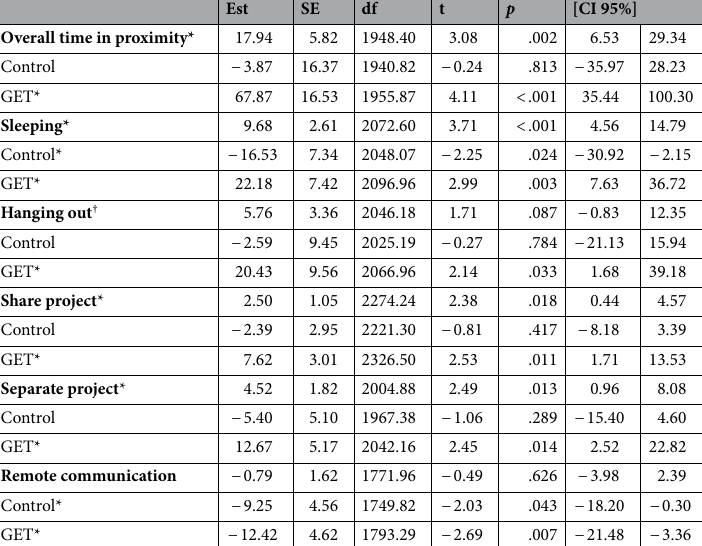
Table 1. Experimental manipulation effects and time changes in each condition. * ,† p < .05 and .10 respectively; each type of time estimate from multi-level models shows the manipulation effect on the type, based on the two-way interaction between experimental manipulation and phase; non-bolded rows for control and GET conditions are the model-estimated changes in time spent in that type of time, within each condition (i.e., the simple effects), and scaled to the unit of